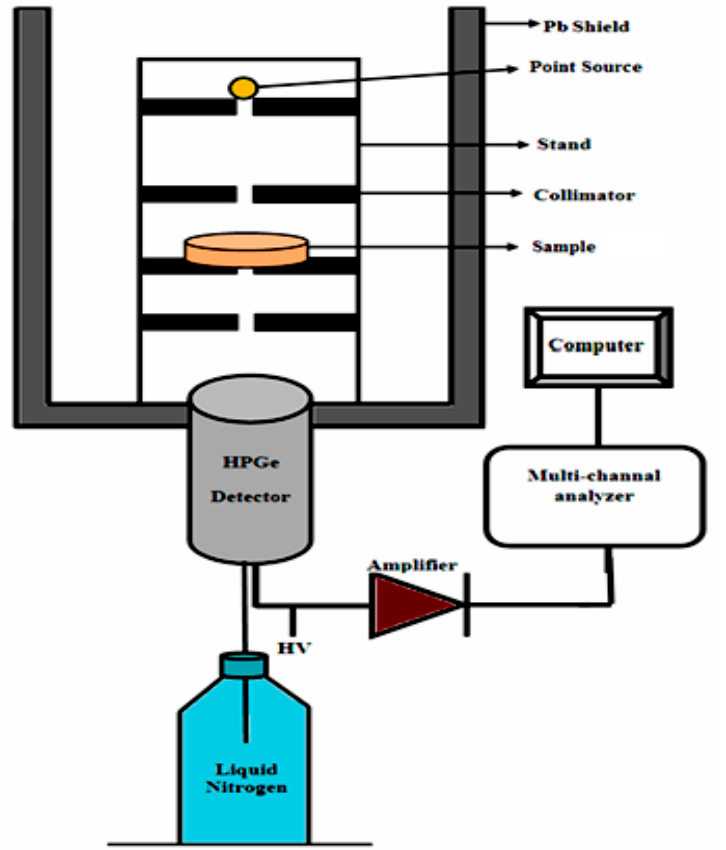
Figure 2. The arrangement of the experimental